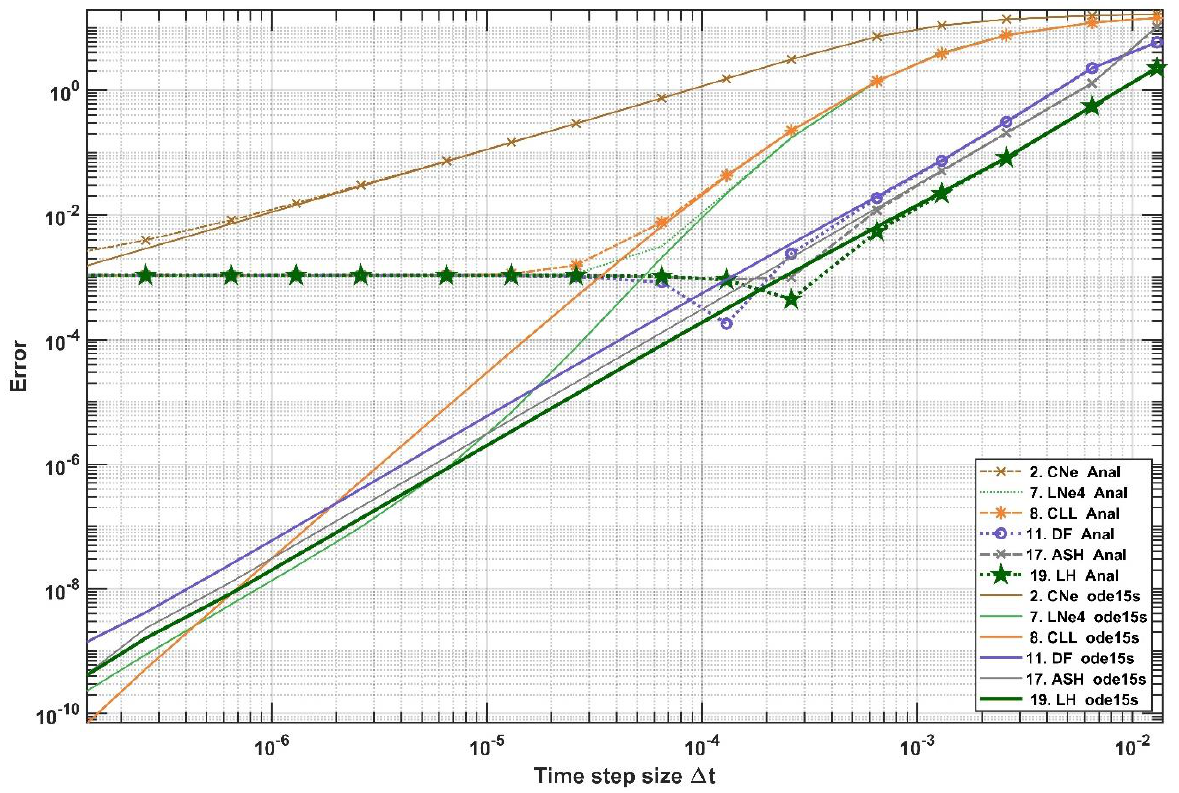
Figure 7. The errors as a function of the time step size for six methods in Experiment 2 when not only the analytical but a numerical reference solution was used to calculate the